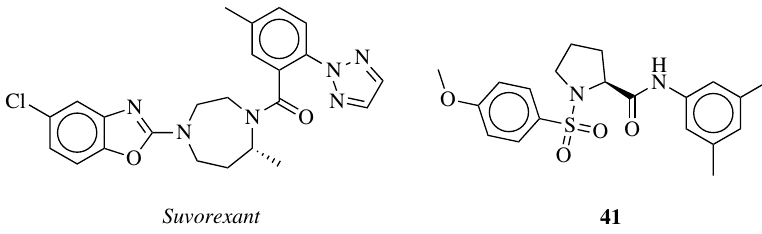
Figure 13. Chemical structures of Suvorexant and clinically tested